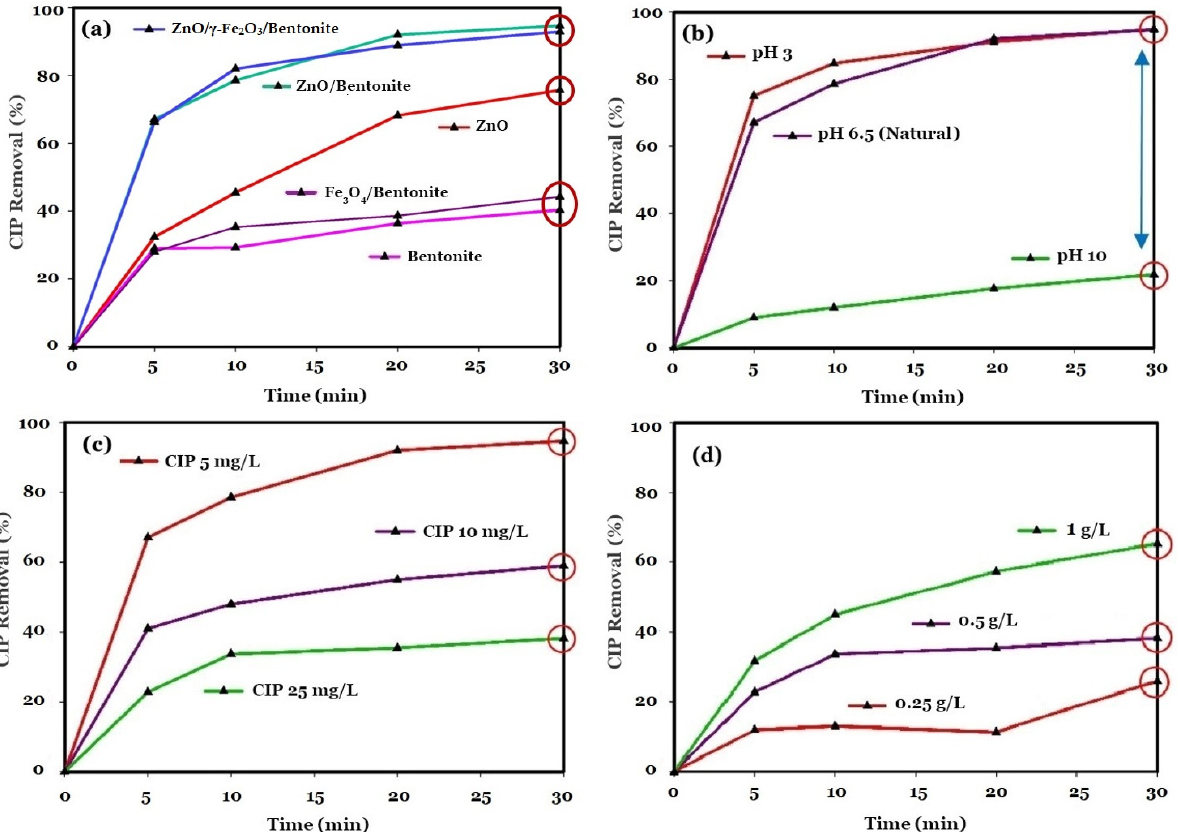
Figure 5. Removal of CIP (5 mg/L) using various types of the applied materials (i.e., bentonite, ZnO/Bentonite, and ZnO/ γ -Fe 2 O 3 /Bentonite: 0.5 g/L) under near neutral pH ( a ). Using ZnO/Bentonite (0.5 g/L) under various initial pH conditions (i.e., 3, 6.5, and 10) ( b ). Removal of various initial CIP concentrations (i.e., 5, 10, and 25 mg/L) by ZnO/Bentonite (0.5 g/L) under initial pH 6.5 ( c ). The effects of various ZnO/Bentonite dosage (i.e., 0.25, 0.5, and 1 g/L) were also studied for the removal of CIP (25 mg/L) under near neutral pH conditions ( d ).